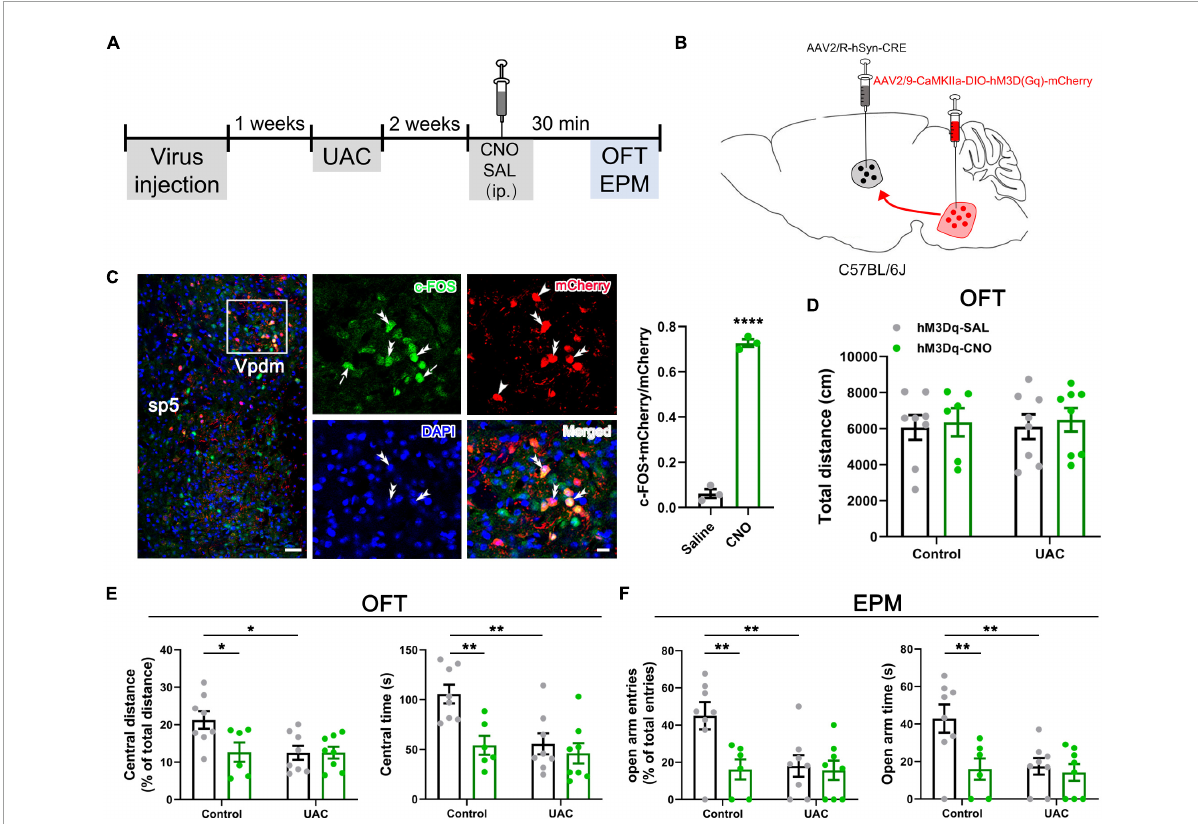
FIGURE6 Chemogenetic activation of the Vpdm-VPM pathway induced anxiety-like behaviors in control mice but did not aggravate UAC-induced anxiety comorbidity. (A) Timeline of the chemogenetic activation of the Vpdm-VPM pathway in the behavioral tests. (B) Virus injection strategy. (C) (Left) Infection images of the hM3D (Gq)-mCherry virus. The white square is enlarged and displayed in the middle. Scale bar: 200 µ m. (Middle) The c-FOS/hM3D(Gq)-mCherry/DAPI triple-labeled neurons after 150 min of CNO injections. The double arrowheads indicate triple-labeled neurons. The arrows indicate c-FOS/DAPI double-labeled neurons. And the single arrowheads indicate the mCherry/DAPI double-labeled neurons. Scale bar: 20 µ m. (Right) The expression of c-FOS in the Vpdm was higher in the CNO-injected group than in the saline-injected group (Saline: n = 3; CNO: n = 3). (D) The general locomotor activities did not differ under various experimental manipulation conditions. (E) The activation of the Vpdm-VPM pathway decreased the percentage of central distance traveled and the time spent in the central area in the OFT in the control mice but did not exacerbate UAC-induced anxiety-like behaviors. (F) The activation of the Vpdm-VPM pathway decreased the percentage of open arm entries and the time spent in the open arms in the EPM in the control mice but did aggravate behaviors induced by UAC. Data are expressed as the mean ± SEM. Tukey’s post hoc was performed between the groups: hM3Dq-SAL-treated control mice ( n = 8) versus hM3Dq-SAL-treated UAC mice ( n = 8) and hM3Dq-SAL-treated control mice versus hM3Dq-CNO-treated control mice ( n = 6). * P < 0.05, ** P < 0.01, **** P < 0.0001.